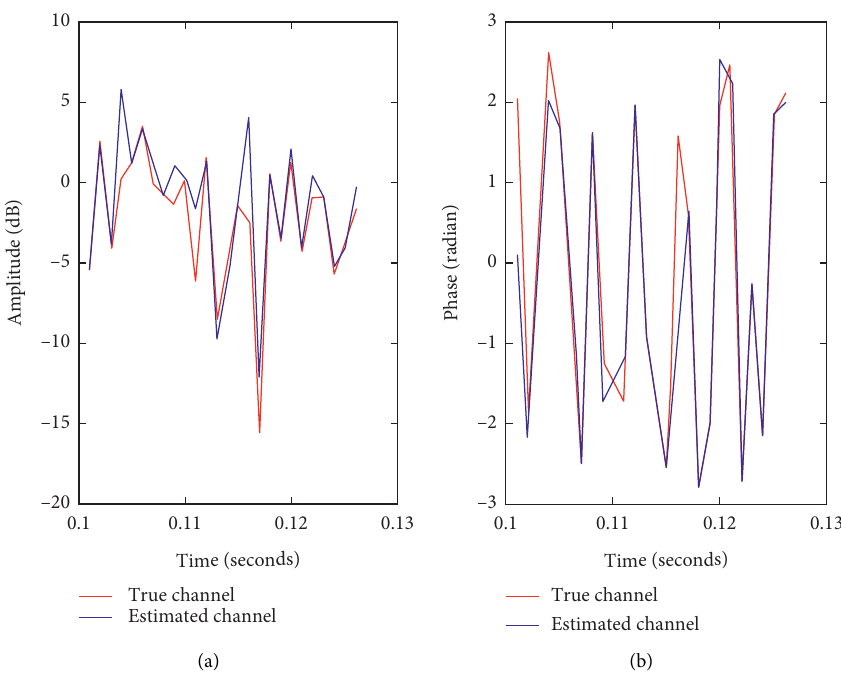
Figure 5: (a) Magnitude and (b) phase of the complex amplitude β